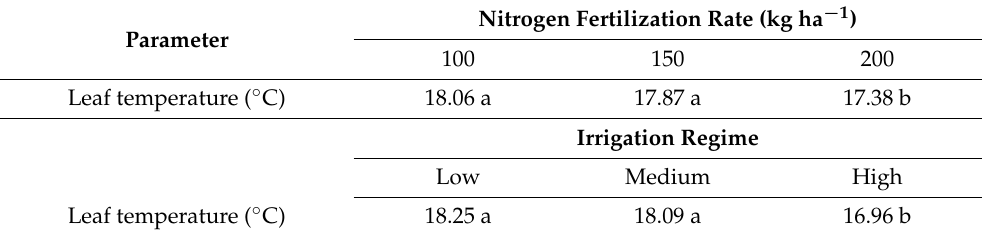
Table 5. The effect of nitrogen fertilizer application rate and irrigation regime on leaf